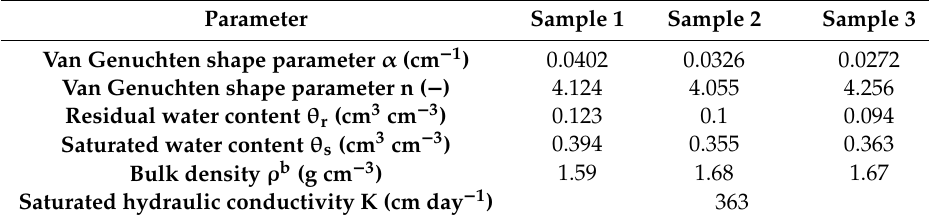
Table 1. Results obtained for van Genuchten retention model (Mualem model-based saturated hydraulic conductivity [24] and pore connectivity were not estimated) by analysis of the retention behavior laboratory data (software: Hyprop data evaluation software 2.0, Co. METER Group, Munich, Germany); hydraulic conductivity estimated using permeameter test after [23]; bulk density estimated by [25].